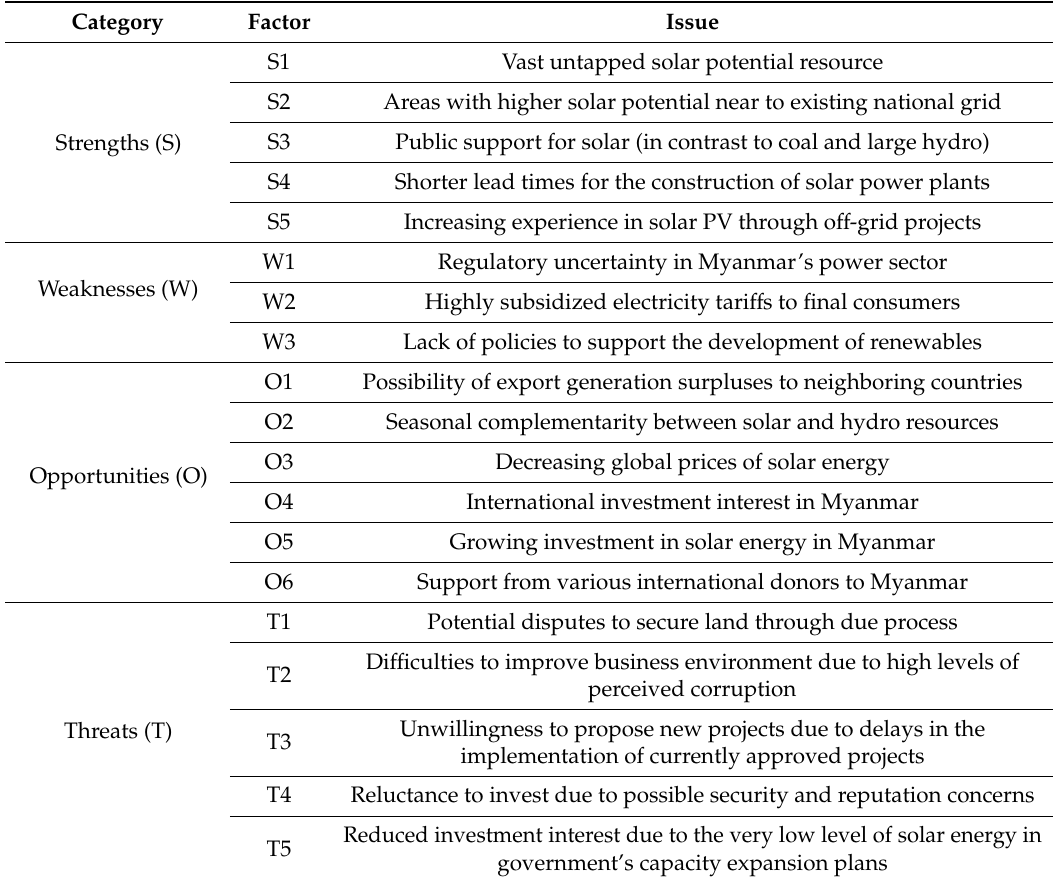
Table 1. Factors identified for SWOT (strengths, weaknesses, opportunities, and threats)